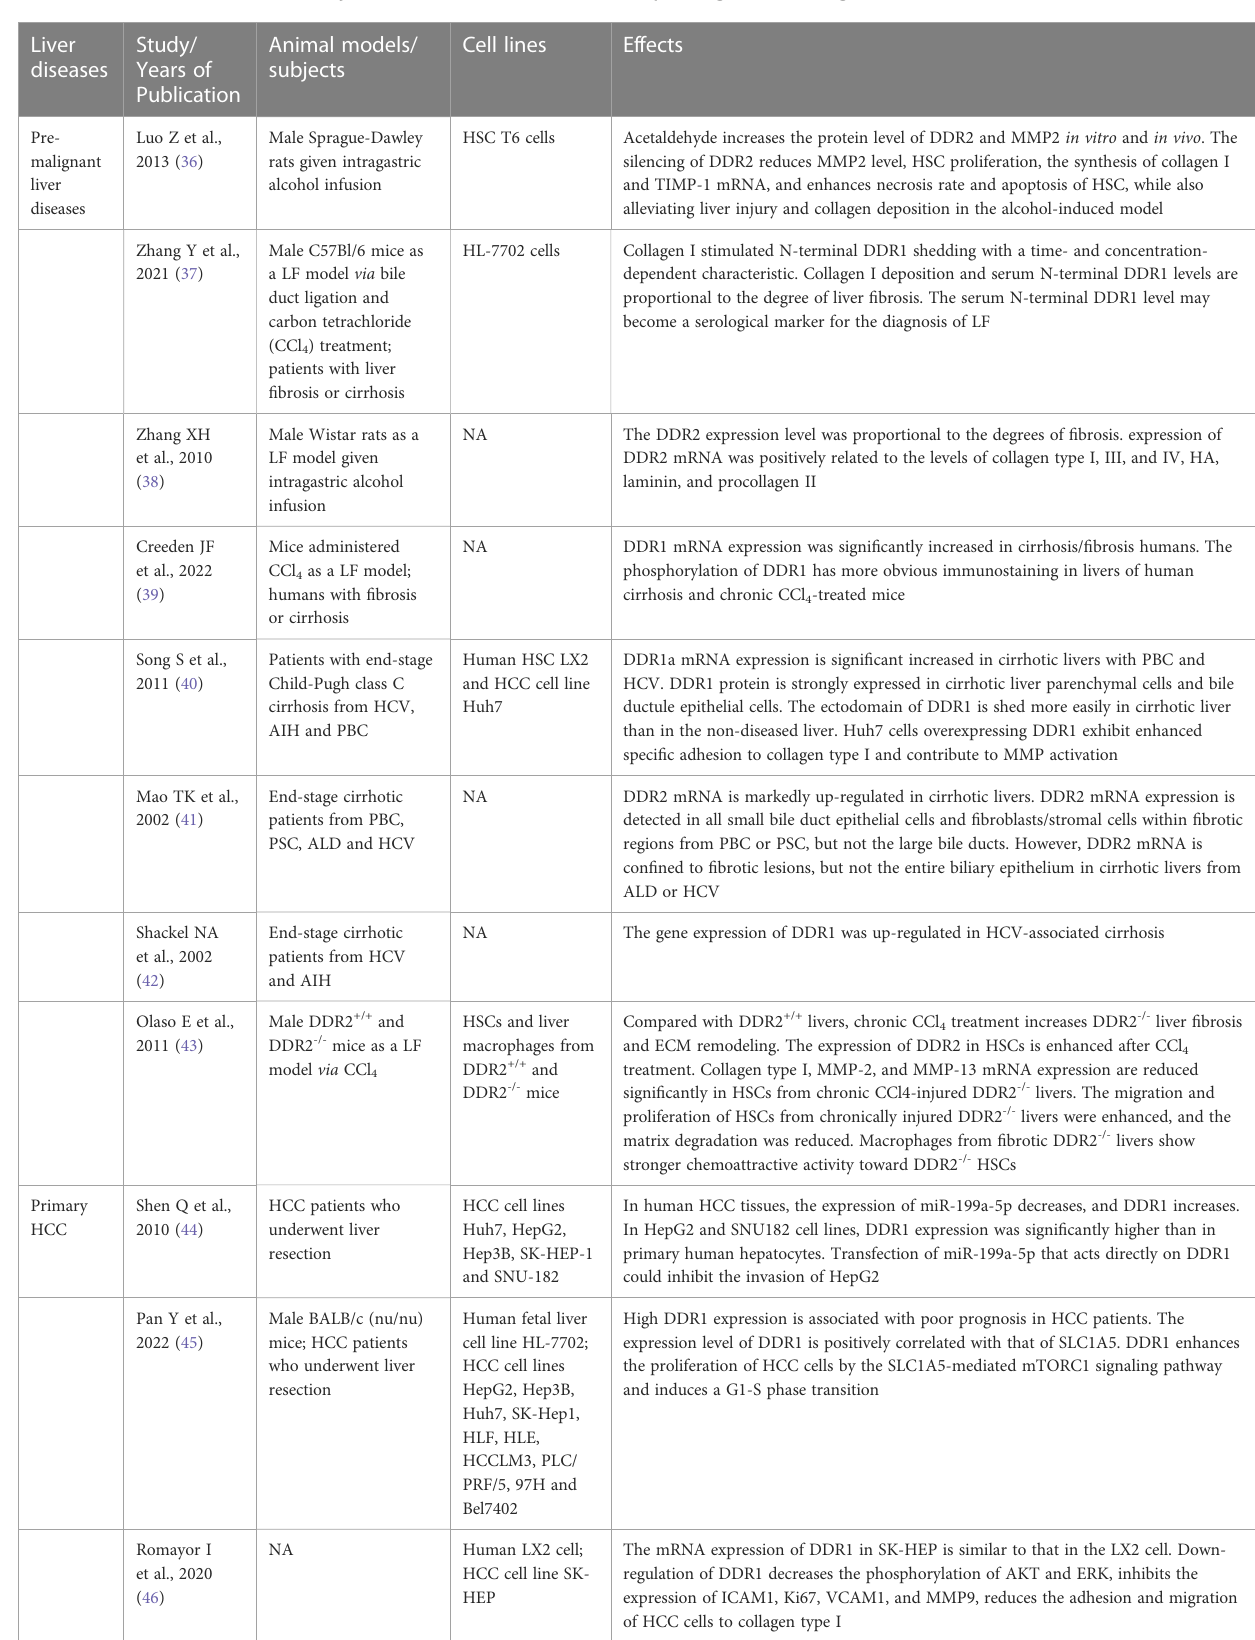
TABLE 1 The list of animal models/subjects, cell lines and effects of DDRs in premalignant and malignant liver